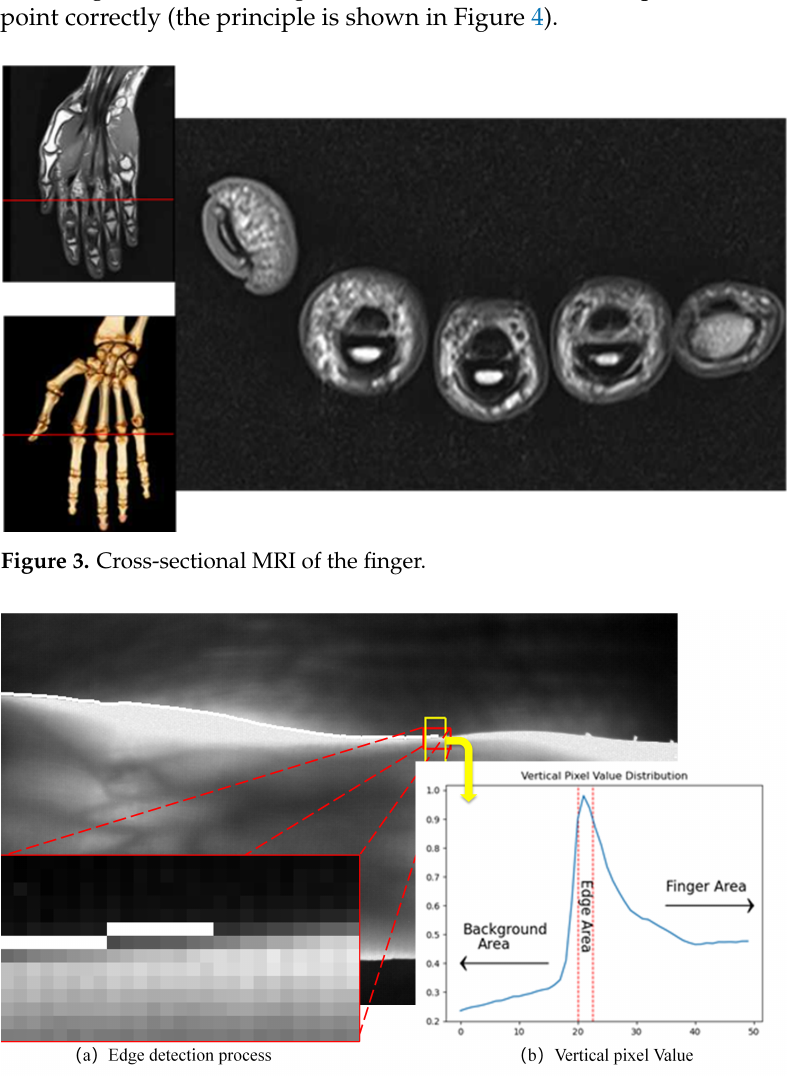
Figure 4. Edge detection process ( a ) Partial zoom during edge detection, ( b ) Column pixel accumula- tion in the area near the finger